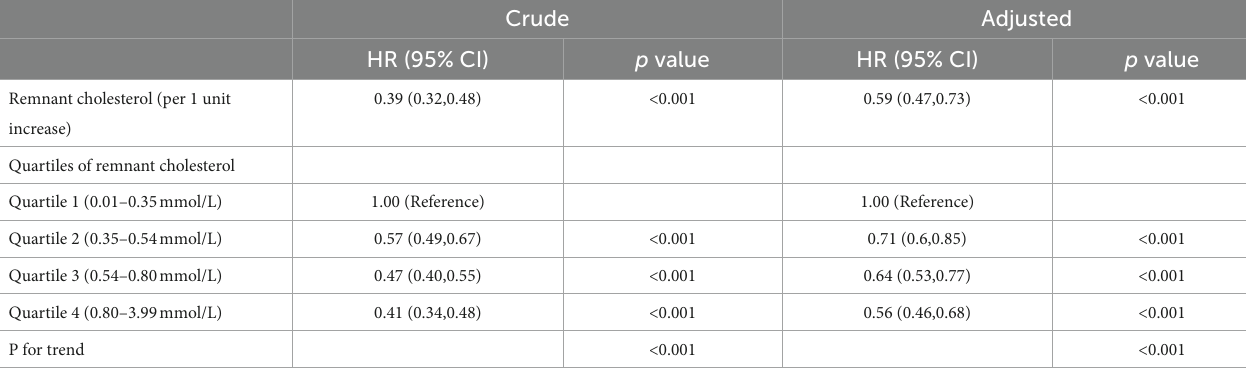
TABLE 4 Hazard ratios for all-cause mortality associated with remnant cholesterol.